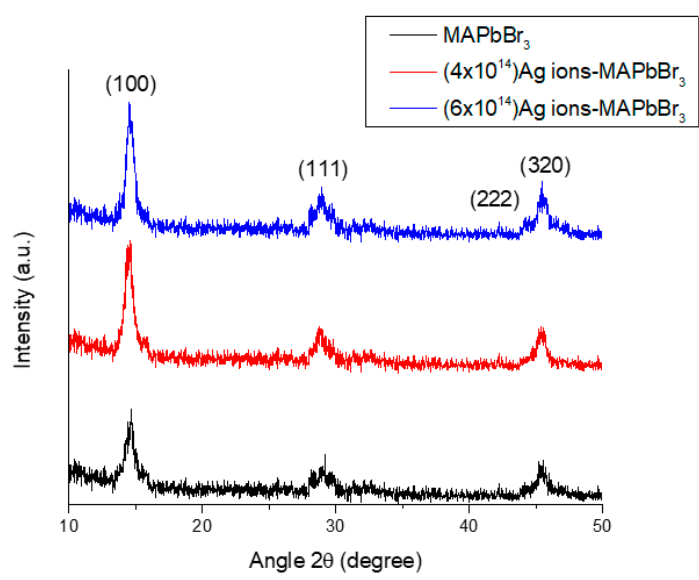
Figure 2. XRD patterns of pure MAPbBr 3 and Ag-MAPbBr 3.